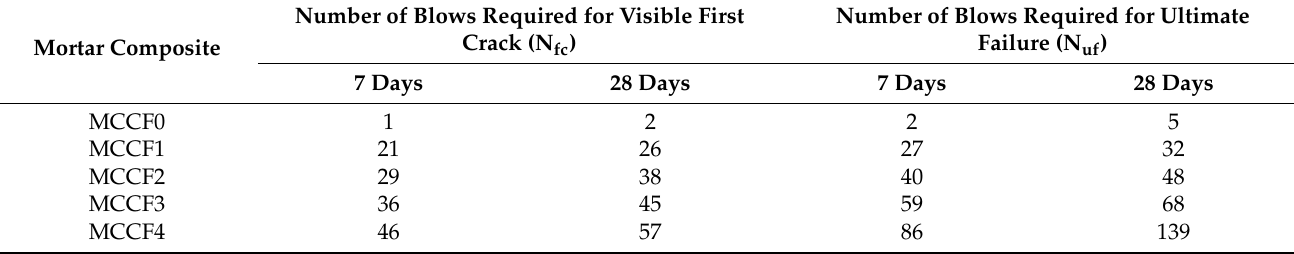
Table 4. Impact resistance of various mortar composites.